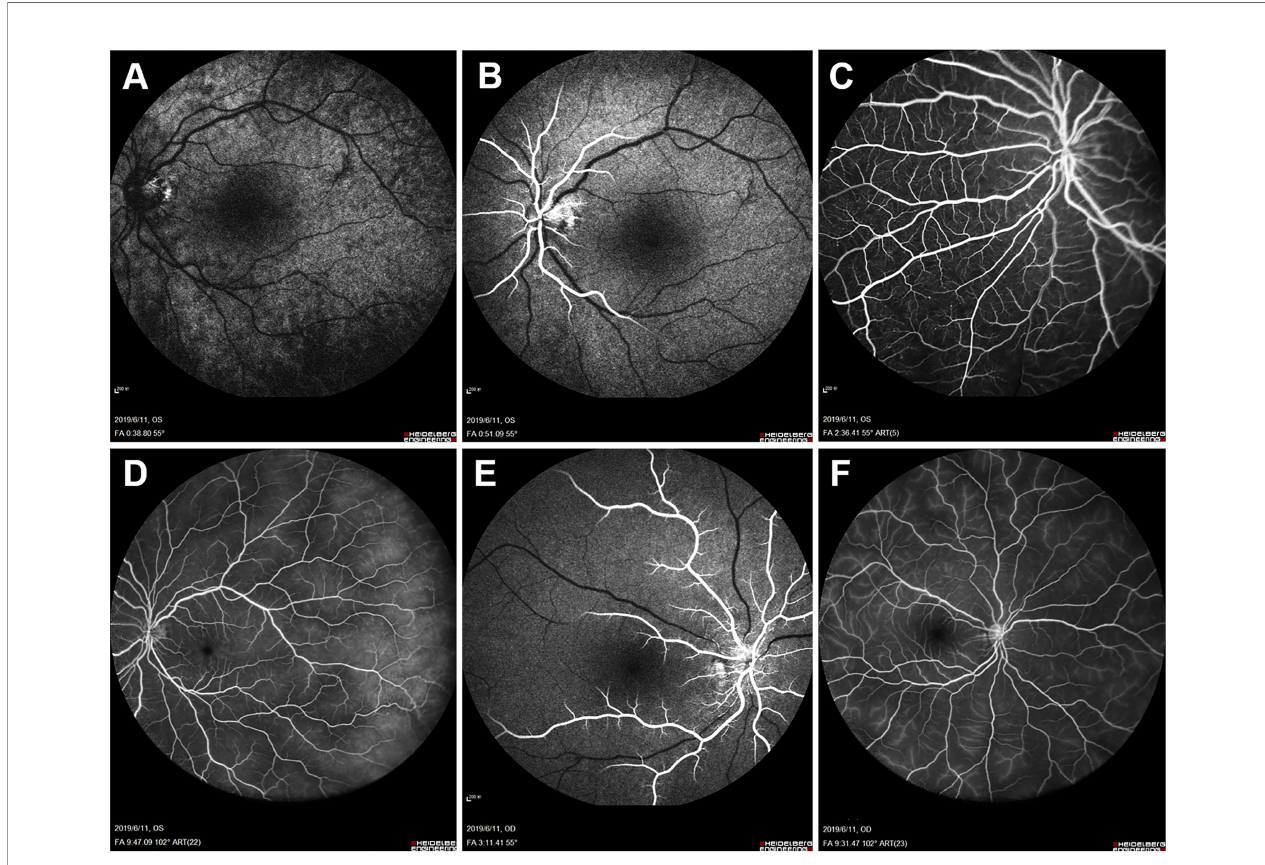
FIGURE 2 | Baseline fundus fl uorescein angiography (FFA). Left eye angiogram reveals (A) patchy choroidal fi lling and a prolonged arm-to-retina circulation time of 38 s. (B) Leading edge of fl uorescein dye in the arteries. (C) Multiple microaneurysms in the midperipheral retina. (D) Diffuse dye leakage in the late phase with mildly dilated retinal veins. Right eye angiogram shows similar changes with (E) delayed arterial fi lling and (F) late-phase dye leakage.